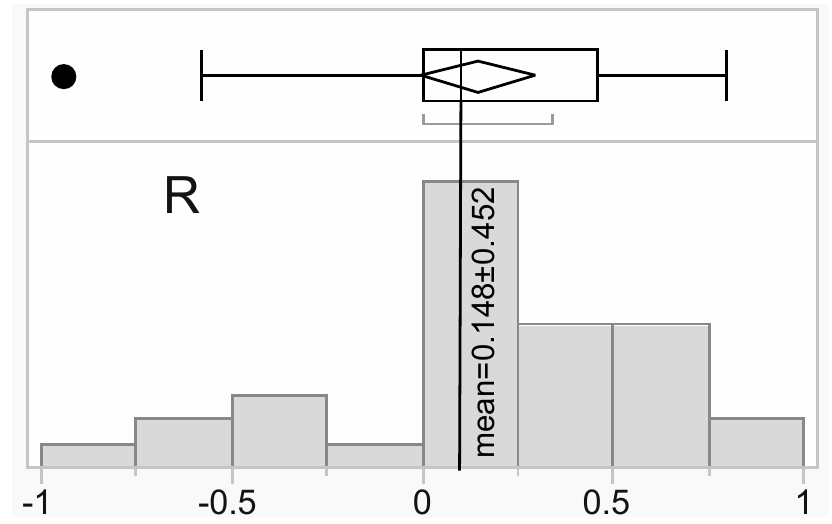
Figure 5. Histogram of gene expression vs. protein concentration correlation coefficient (R) values. The global mean has been shown as a vertical line, and the error terms represents standard deviation.